Question: Write a caption explaining this figure to a reader.
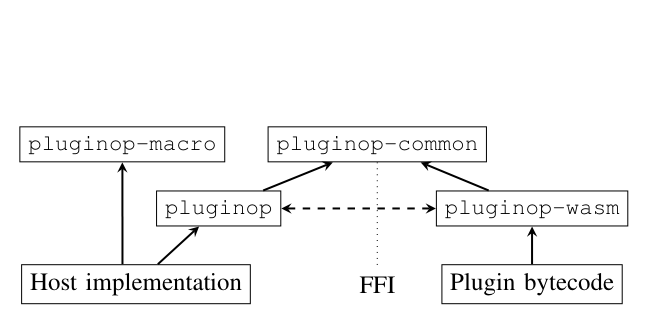
Answer: Architectural view of the different components of pluginop. Plain arrows mean ”uses”, dashed arrows mean ”interacts”.